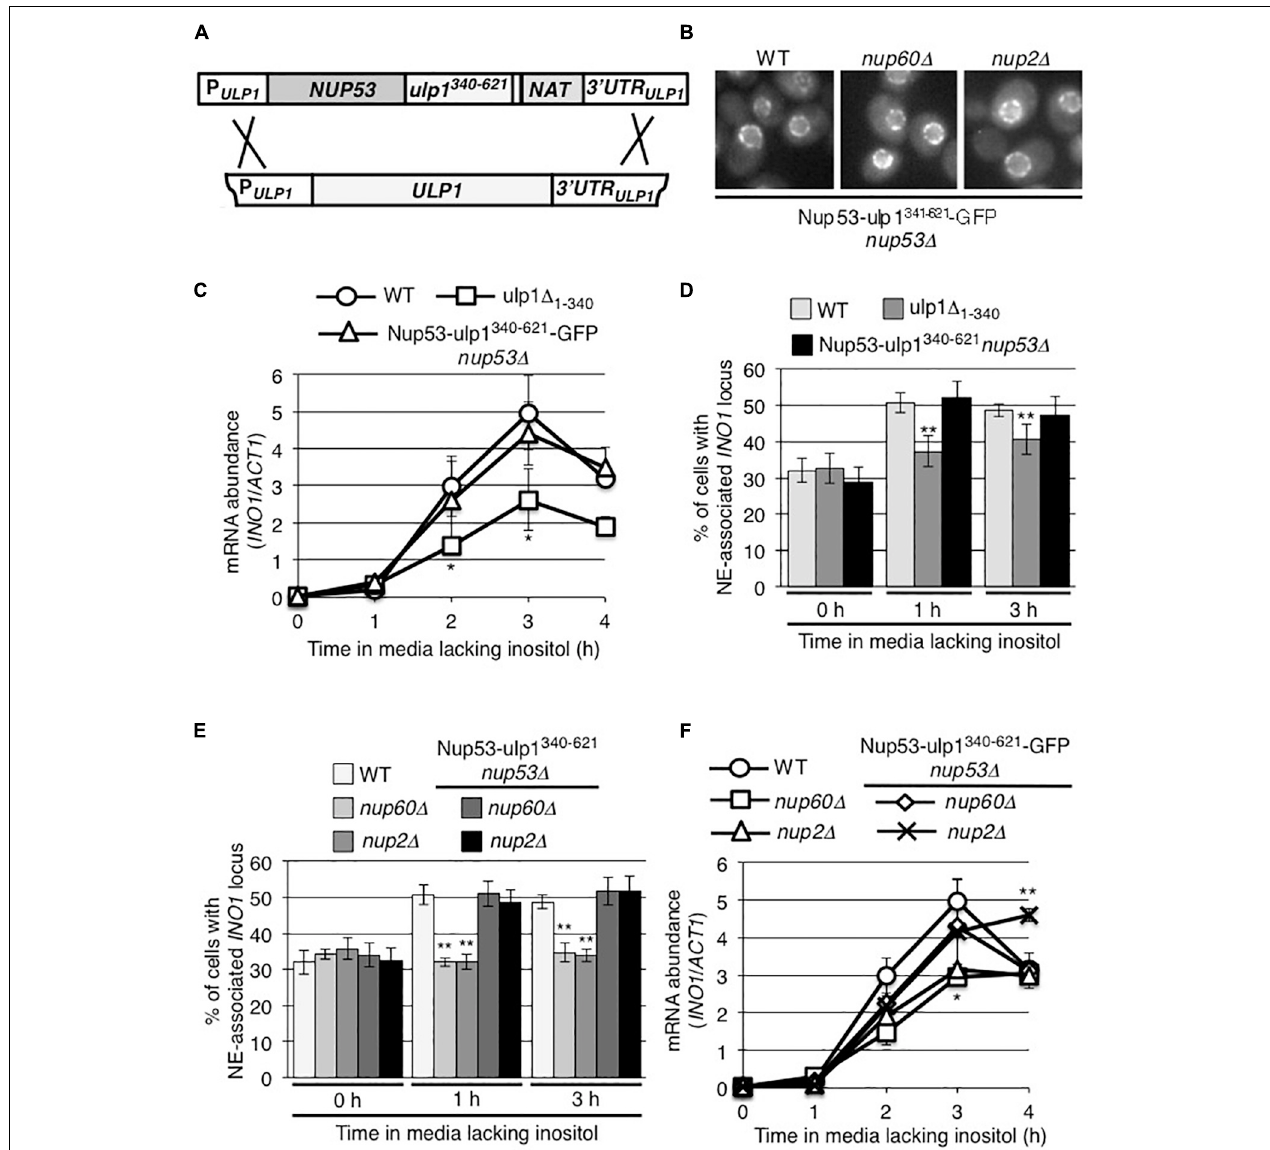
FIGURE 7 | The NPC association of the C-terminal domain of Ulp1 is sufficient to support recruitment of induced INO1 . (A) Endogenous ULP1 was replaced by a NUP53-ulp1 340 - 621 chimera under the control of the ULP1 promoter in a haploid yeast strain. A schematic representation of the construction of this chimeric gene is shown. (B) Localization of the Nup53-ulp1 340 - 621 fusion protein C-terminally tagged with GFP was examined in an otherwise WT background or in strains lacking NUP60 or NUP2 . (C,F) Levels of mRNA encoded by the INO1 gene were evaluated by qRT-PCR following induction for the indicated times; (C) in WT, NUP53-ulp1 340 - 621 , and ulp1 (cid:49) 1 - 340 strains and (F) in WT, nup60 (cid:49) , nup2 (cid:49) , NUP53-ulp1 340 - 621 nup60 (cid:49) , and NUP53-ulp1 340 - 621 nup2 (cid:49) strains as described in Figure 2 . Results are the means ± SEM of three biological replicates. (D,E) Localization of the INO1-lacO 256 locus was examined prior to (0 h) or at 1 and 3 h after induction in the indicated strain backgrounds. Note that the data shown here for ulp1 (cid:49) 1 - 340 in D are the same as that in Figure 5A and are shown here for comparison. Localization of INO1-lacO 256 locus was assessed as described in Figure 2 . Results are the means ± SD of at least three biological replicates. For D and E , at least 100 cells were counted for each replicate. Asterisks indicate a significant difference from WT samples at the corresponding time points as indicated by Student’s unpaired t -test. * p < 0.05, ** p <